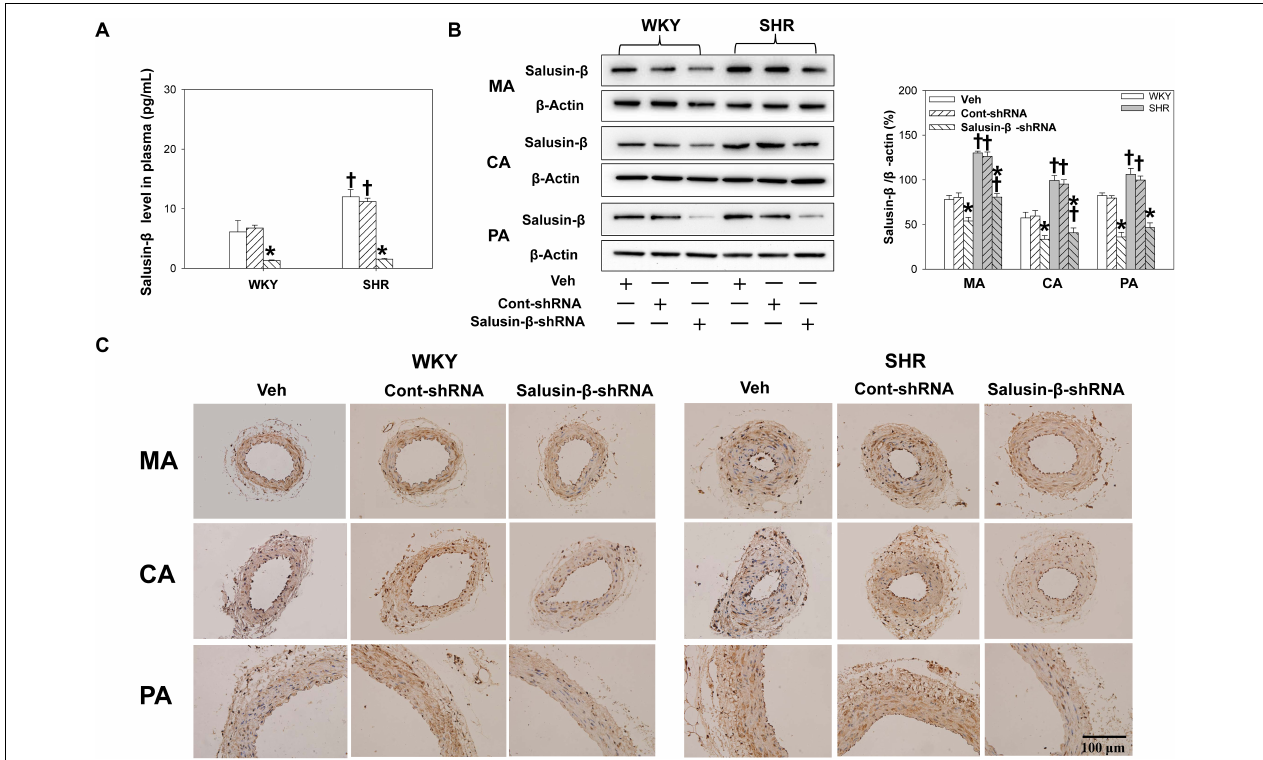
FIGURE 1 | The salusin- β level in plasma (A) , and salusin- β protein expression of MA, CA, and PA in WKY and SHR detected by western blot (B) and detected by immunohistochemistry (C) after salusin- β knockdown. Two-way ANOVA was used for data analysis, followed by Bonferrioni post hoc test to compare with the multiple groups. Values are mean ± SE. ∗ P < 0.05 compared with Veh or Cont-shRNA, † P < 0.05 compared with WKY. n = 6 for each group.